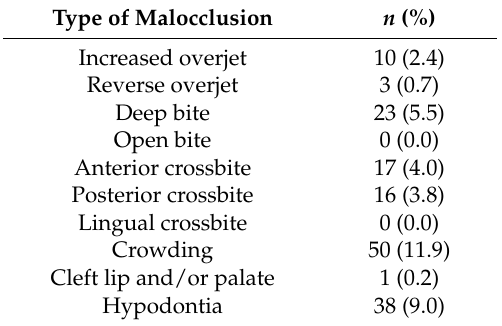
Table 2. Distributions of the different types of malocclusion in the study sample.